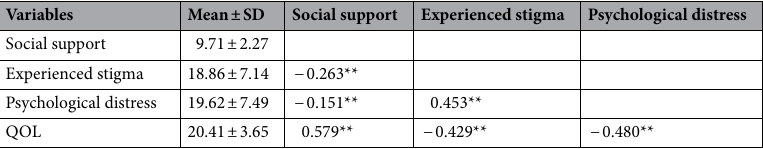
Table 2. Descriptive statistics and correlations among study variables. QOL quality of life, SD standard deviation. All correlations were significant. ** P < 0.01.